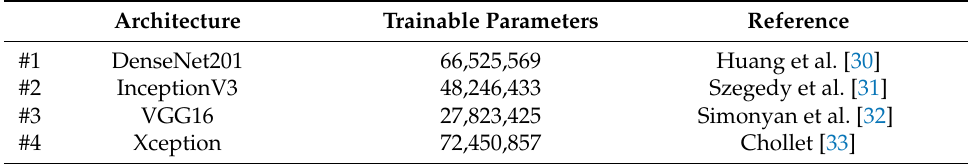
Table 1. Convolutional neural network architectures adopted.